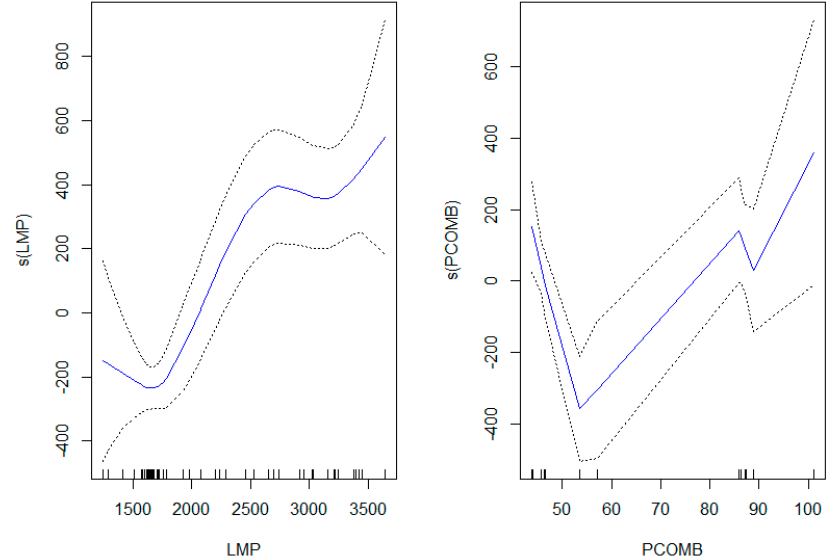
Figure 6. Smoothing spline functions (fitted function and pointwise standard errors).